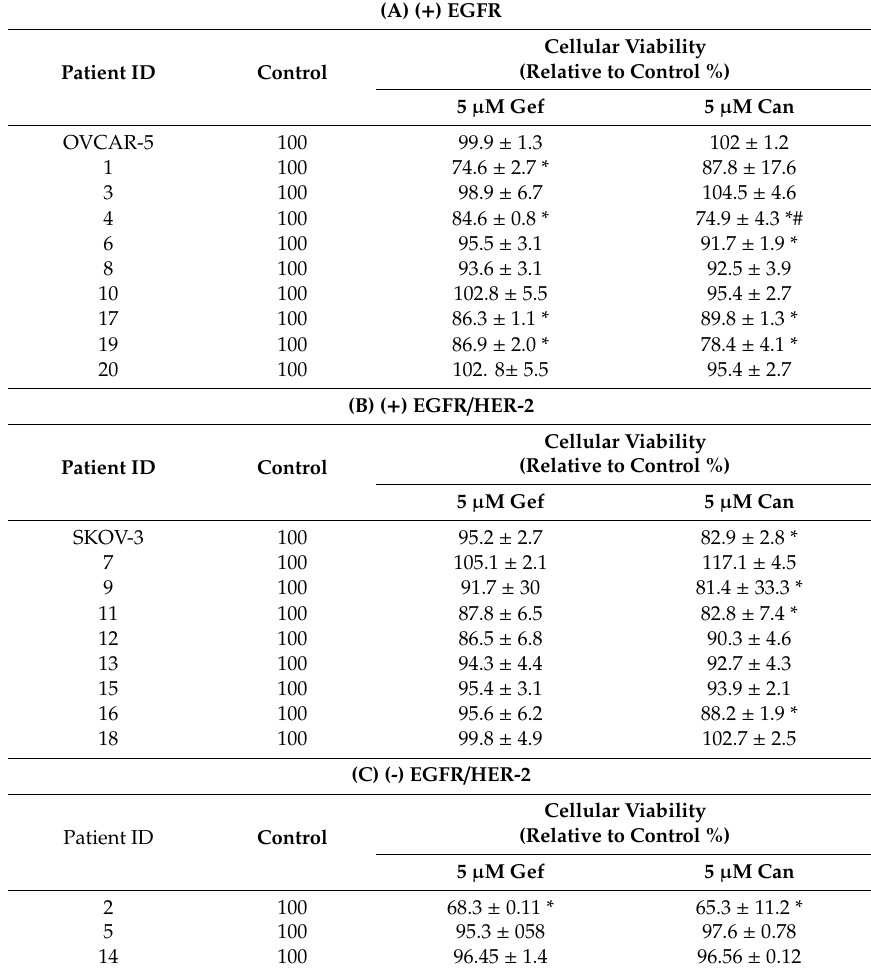
Table 3. Cellular viability of OVCAR-5, SKOV-3 and ascitic derived cells from 20 patients are a ff ected by gefitinib (Gef) and canertinib (Can). Nine patient cell lines and the OVCAR-5 cells expressing EGFR only, have a decrease in viability by the treatment of Gef and Can ( A ). Eight patient cell lines and SKOV-3 cells expressing both EGFR and HER-2 do not respond to Gef, but have increased responsiveness to Can ( B ). Only one cell sample of EGFR / HER-2 negative cells responded to both gefitinib and canertinib ( C ). Representative analysis was from a set of two independent experiments, and each experiment had three duplicates. Mean ± SE; n = 2 is presented and statistical significance was determined by a t -test ( * , p < 0.05). The statistical di ff erence between gefitinib and canertinib treated cells was determined by a t -test (#, p <